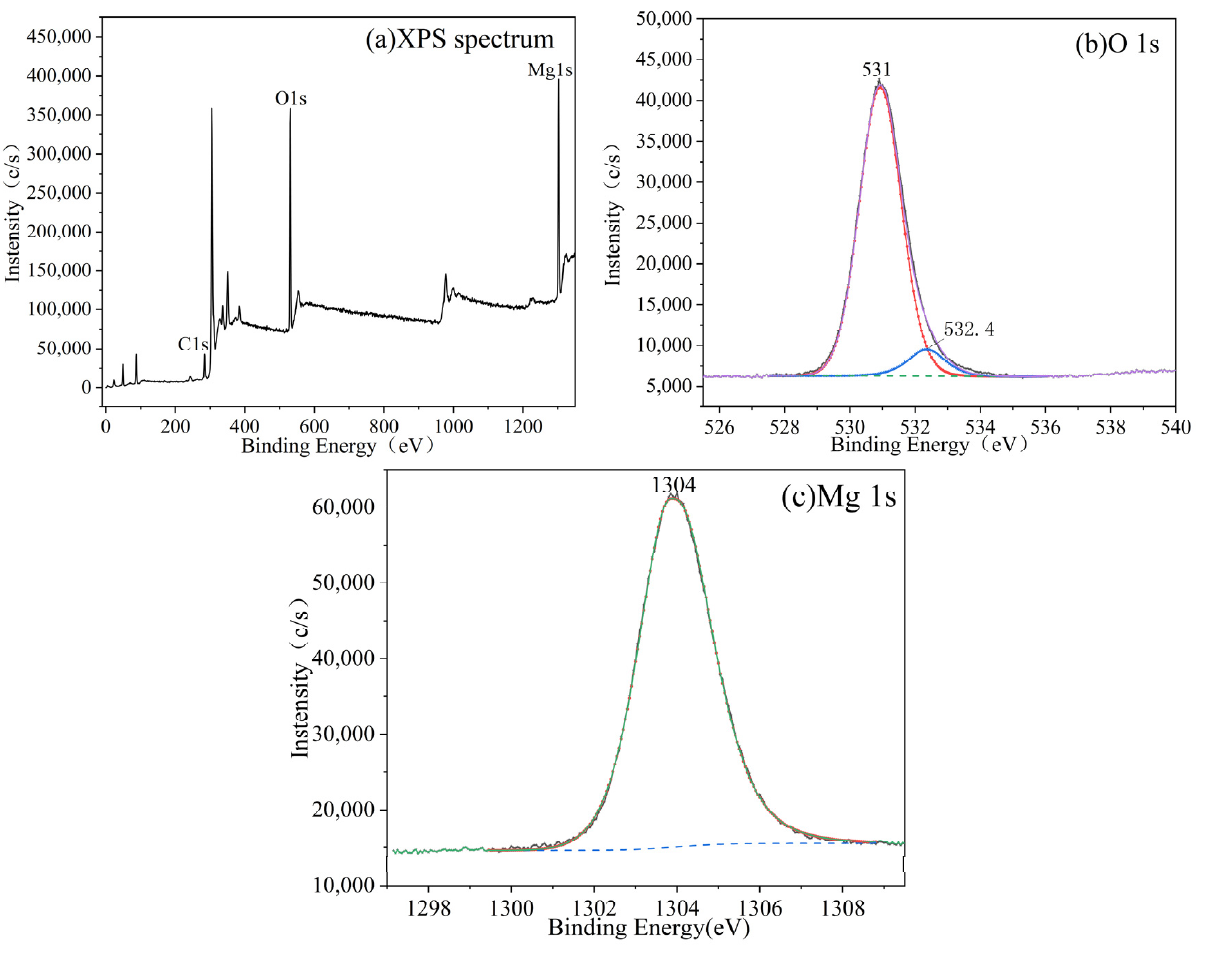
Figure 8. XPS profile of the products with 0 wt% CS ( a ), and high-resolution XPS profiles of O 1s ( b ) and Mg 1s ( c ). Table 1. Elemental content of the products of 0 wt% CS analyzed using XPS. Element